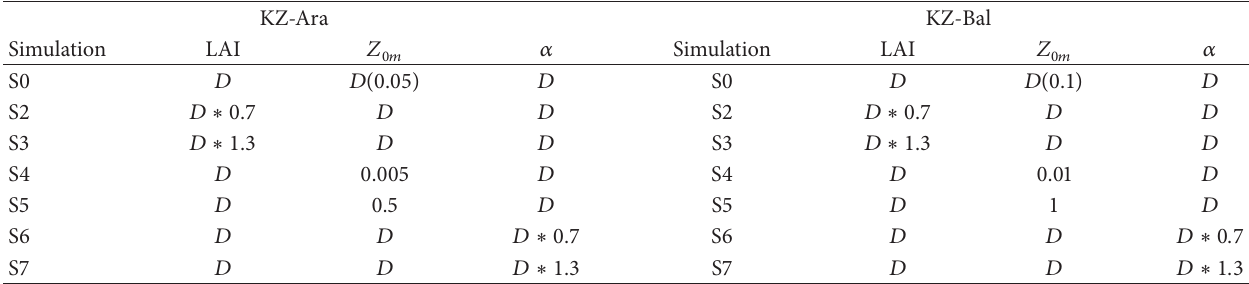
Table3:Abaselineofreferenceexprement(S0)andsixdifferentconfigurationsofCLMateachsite(S2–S7),asusedinthisstudyforsensitivity testing. Two sets of leaf area index (LAI), average roughness length ( 𝑍 0𝑚 ), and average albedo ( 𝛼 ) were used in CLM. “ 𝐷 ” refers to the model default parameter